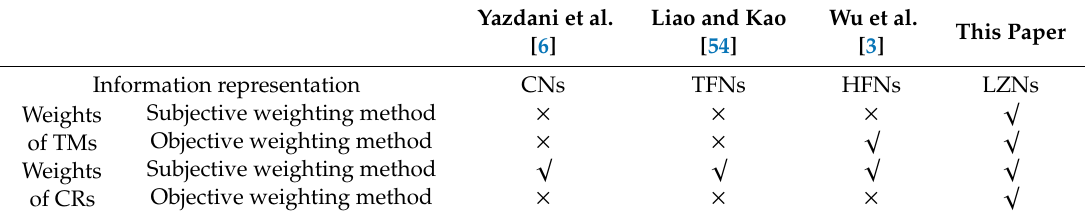
Table 13. The comparative analysis of integrated QFD